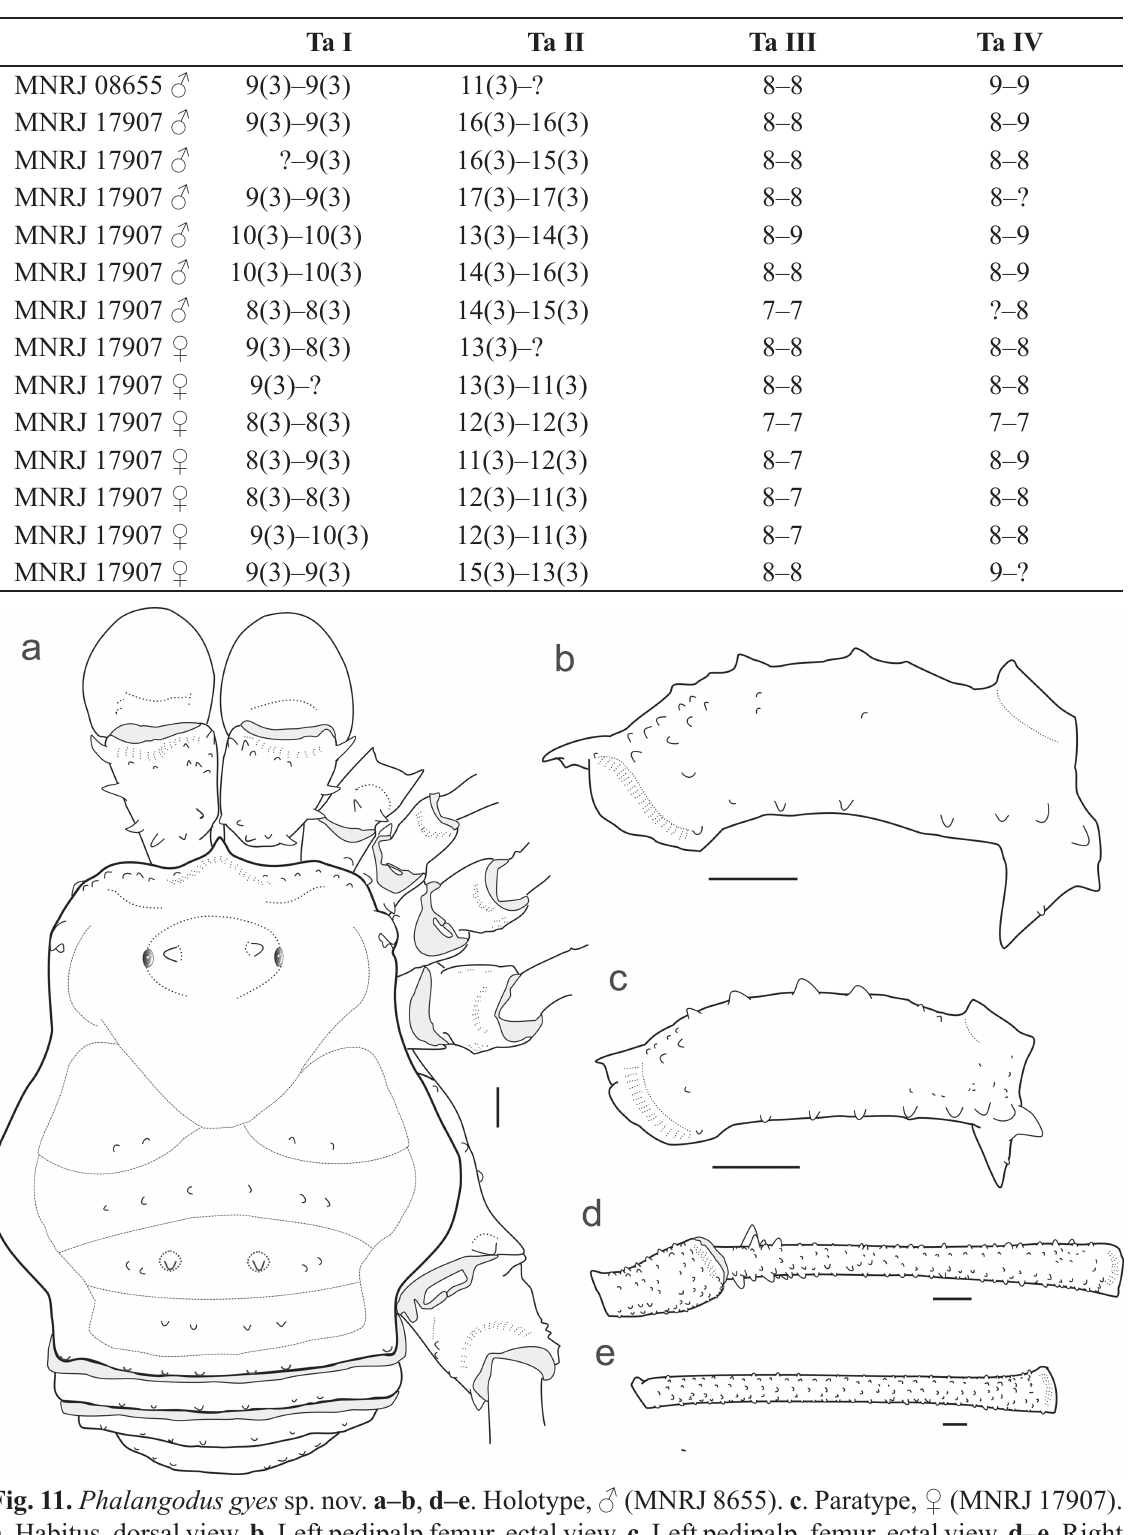
Table 6. Tarsal formula of Phalangodus gyes sp. nov. (numbers in parentheses are the number of